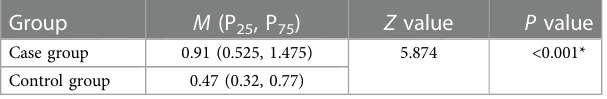
TABLE 1 Comparison between case and control groups of NLR with Wilcoxon